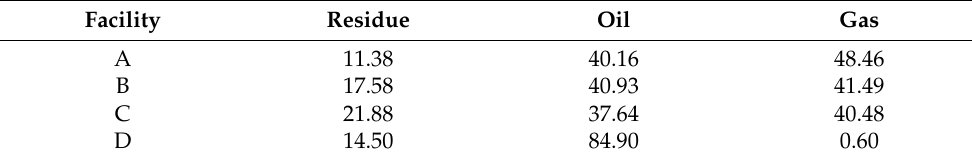
Figure 2. Pyrolysis gas components and concentration. Table 4. Material balance of pyrolysis residue, oil, and gas (Unit: wt%).